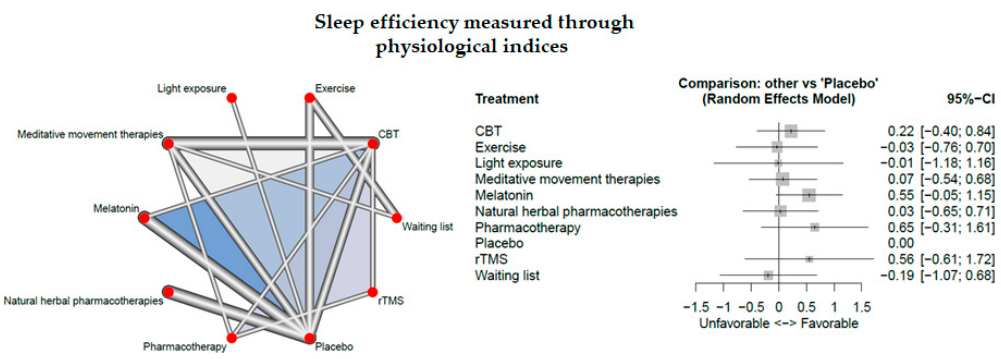
Figure 4. Sleep e ffi ciency measured through physiological indices.